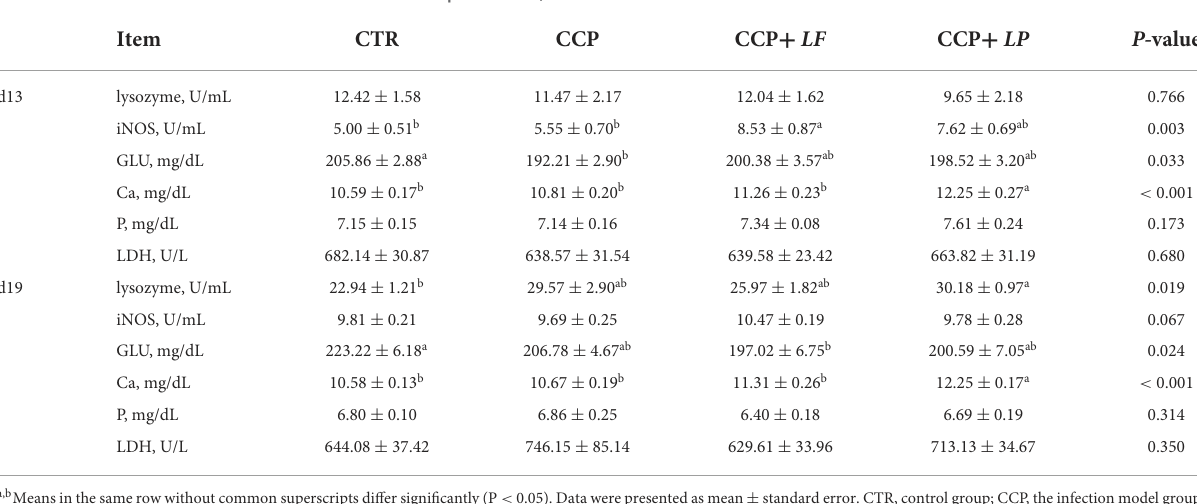
TABLE 5 The levels of serum immune and biochemical parameters, n = 12.